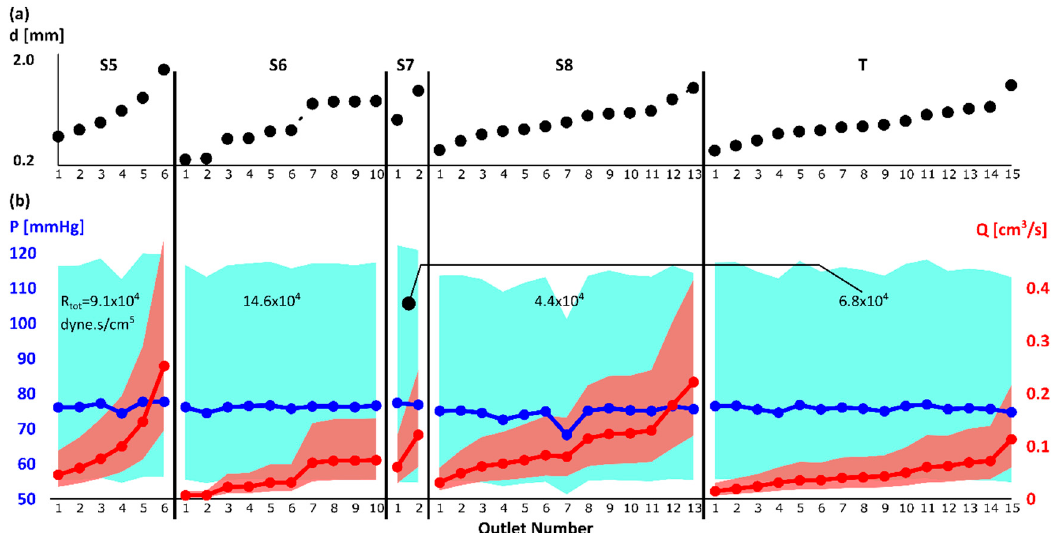
Figure A1. ( a ) Outlet diameter: The outlets to each liver segment were numbered with increasing diameter; ( b ) outlet average pressure P avg (blue solid line) and flow rate Q avg (red solid line). The blue and red shadows show the range [ P min , P max ] and [ Q min , Q max ], respectively. For the results shown in this figure, the R tot was 6.8 × 10 4 dyne·s/cm 5 and R d / R p was 1 for S7 (which included T). The outlet pressure did not present a relationship with the outlet diameter (Solid blue line in Figure A1). The average pressure ( P avg ± SD) did not change with the diameter and was 77.7 ± 1.5 mmHg. For other cases not shown here, P and Q showed similar trends with a fixed R d / R p ratio and varying R tot .